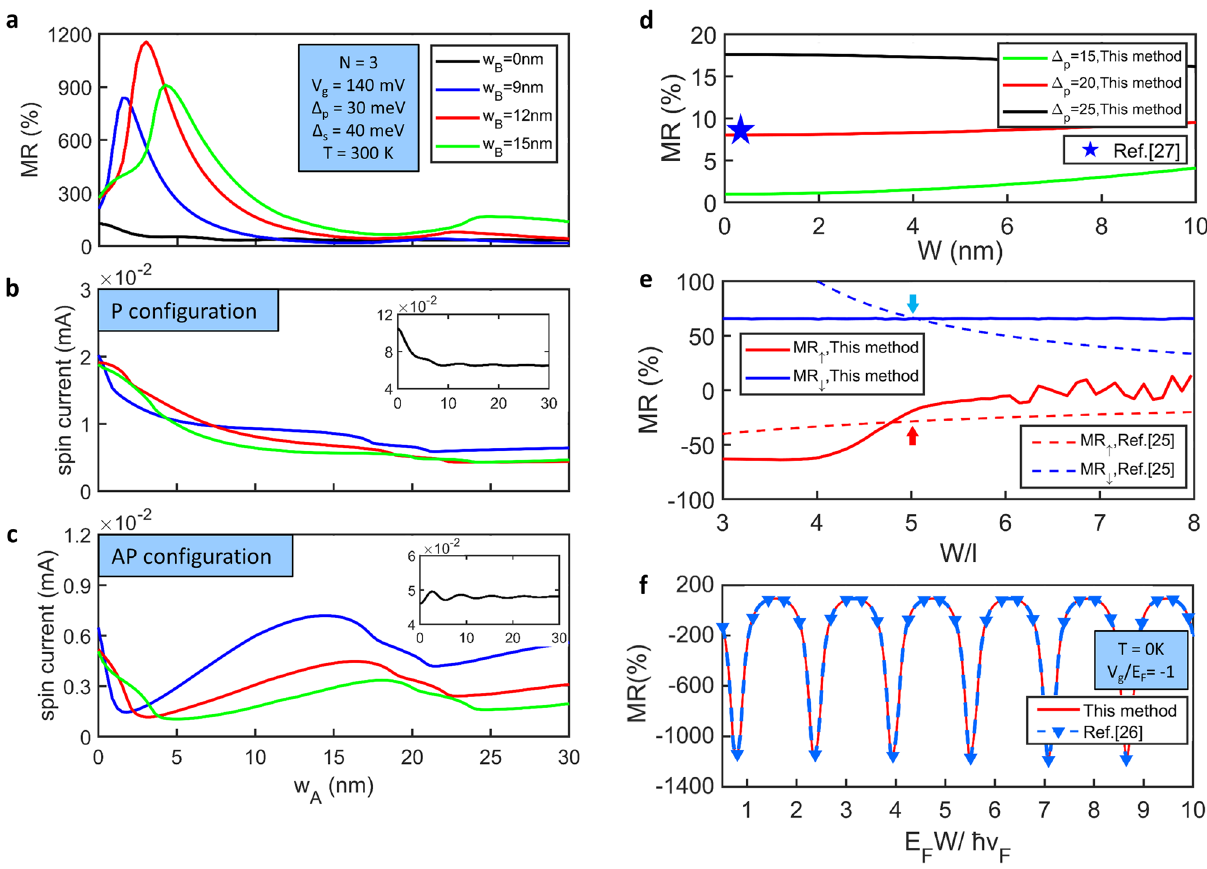
Figure 2. ( a ) Room-temperature MR ratios versus the length between two gates in 3-cell spin valves with w B = 0 nm, w B = 9 nm, w B = 12 nm, and w B = 15 nm. Spin-polarized current in the ( b ) parallel and ( c ) antiparallel configurations as a function of w A with different gate lengths at room temperature. The insets depict the spin- polarized currents in a standard TITF spin valve ( w B = 0 nm). ( d ) MR ratio obtained by the proposed TITF spin valve with different proximity exchange splitting at an extremely low temperature, T = 4 K. ( e )( f ) MR simulation corresponding to the works described in references 25,26 25, 26, theoretically. l and E F are the mean-free path and the Fermi